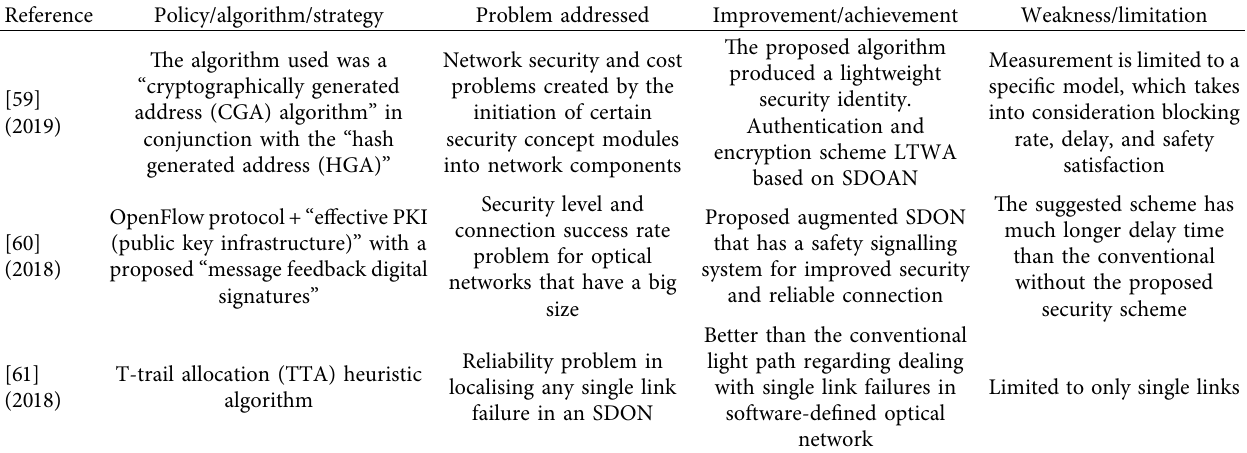
Table 11: Reliability and security solution implementation for